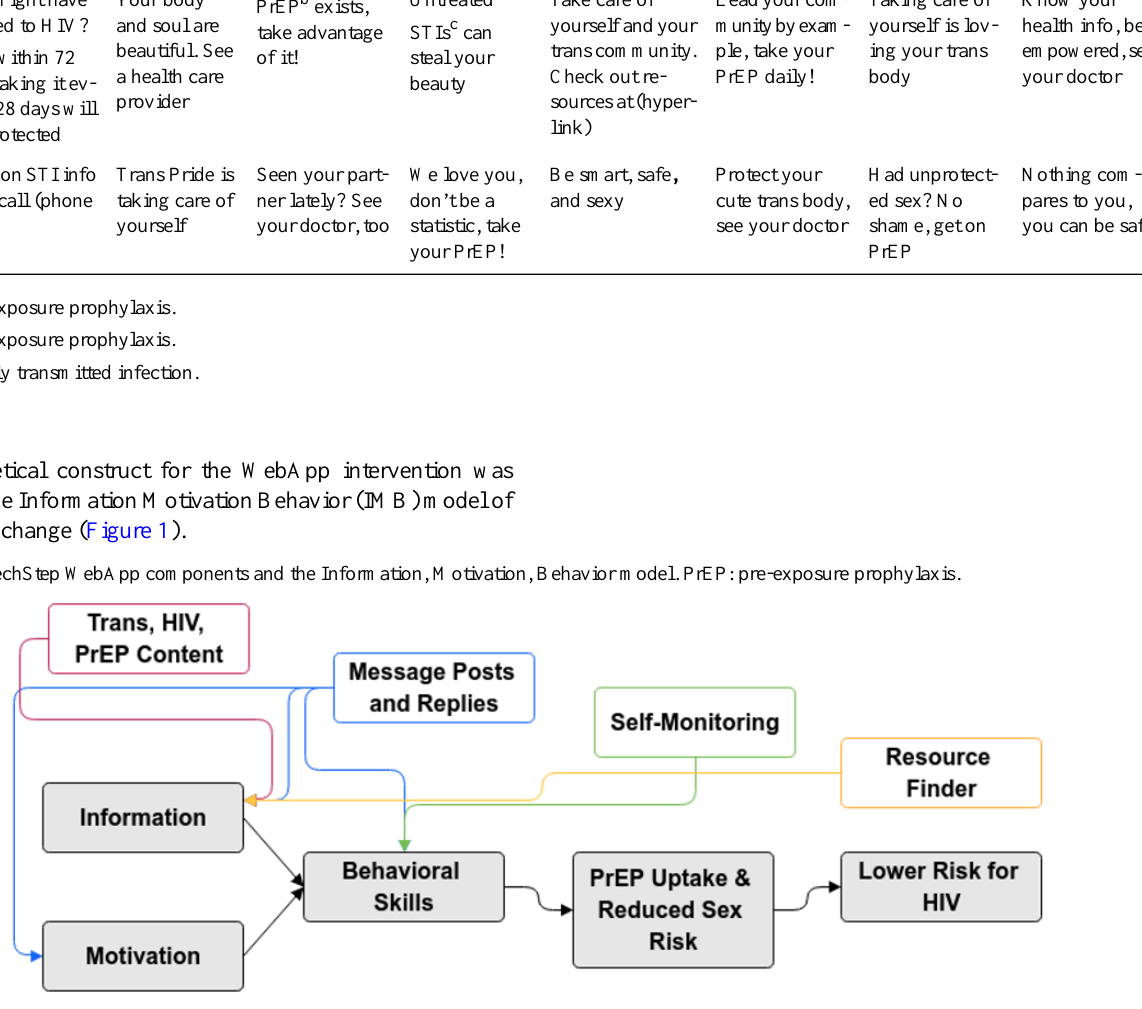
Table 1. Sample of scripted text messages by behavioral change theory.